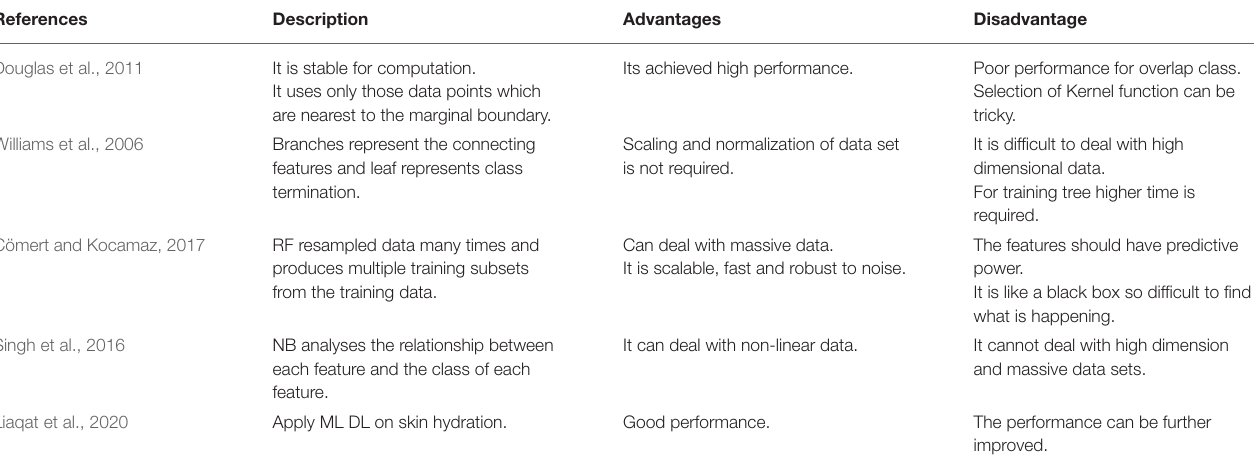
TABLE 2 | Advantages and disadvantages of different approaches for classification of AF and Skin Hydration